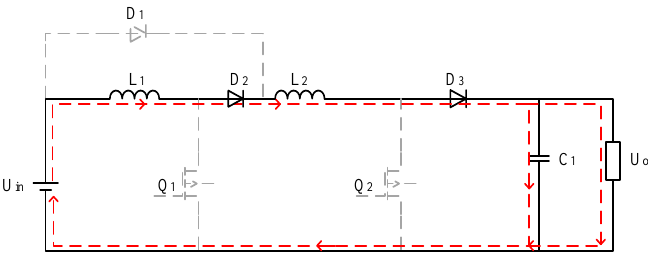
Figure 3. Converter operating mode in OFF state.